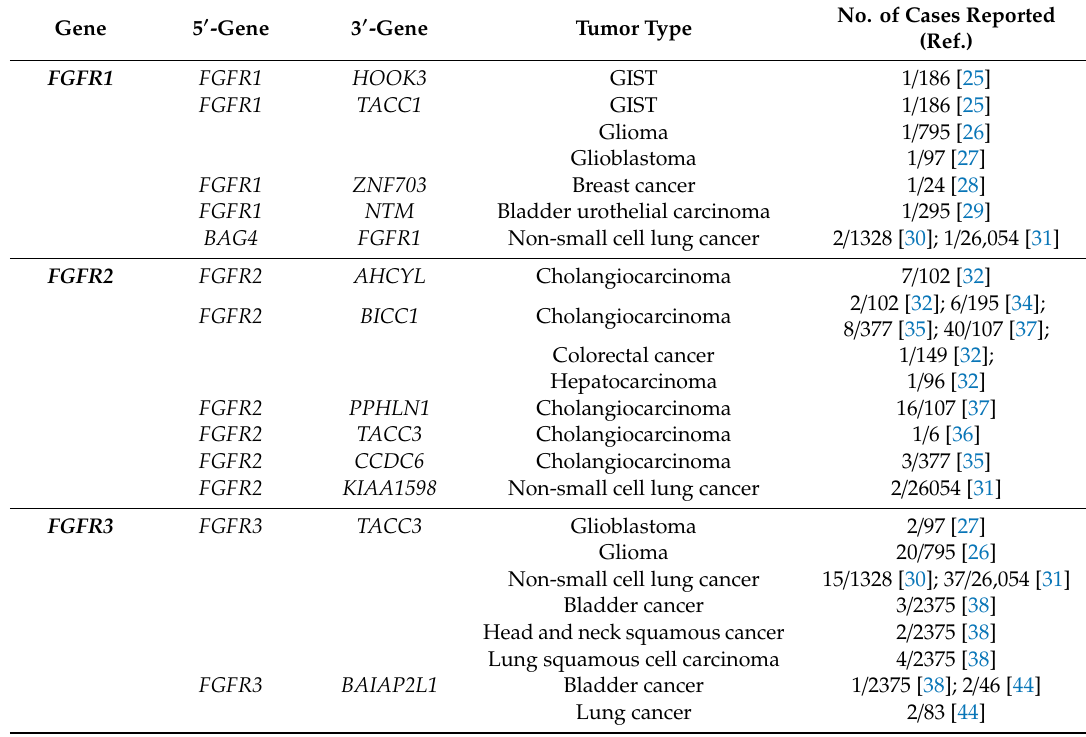
Table 1. Most frequent fibroblast growth factor receptor (FGFR) fusions in solid tumors.